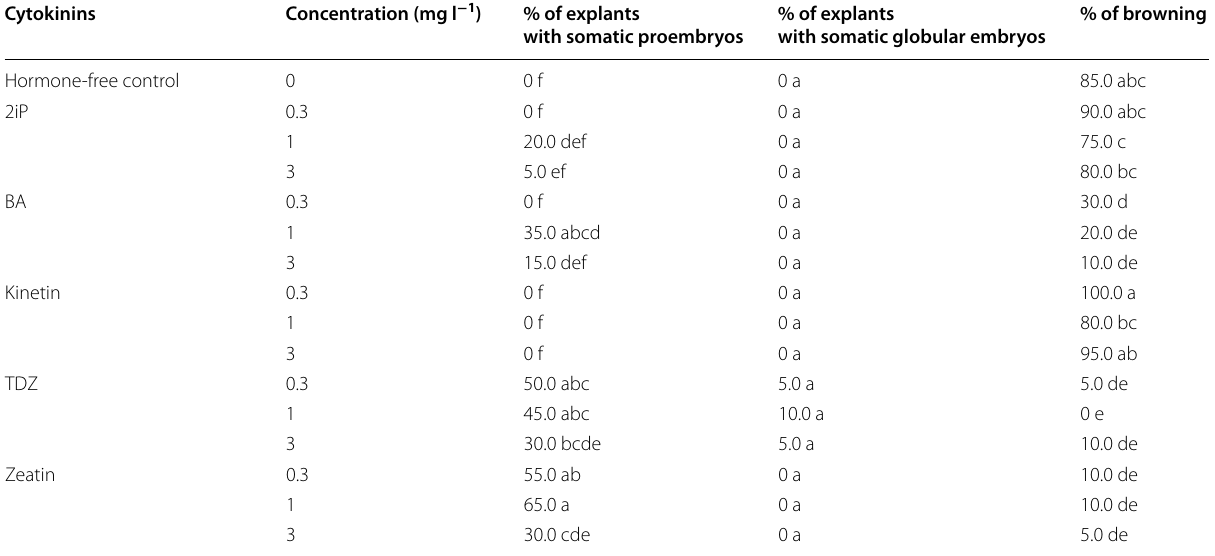
Means within a column followed by the same letter are not significantly different according Duncan’s multiple range test at p